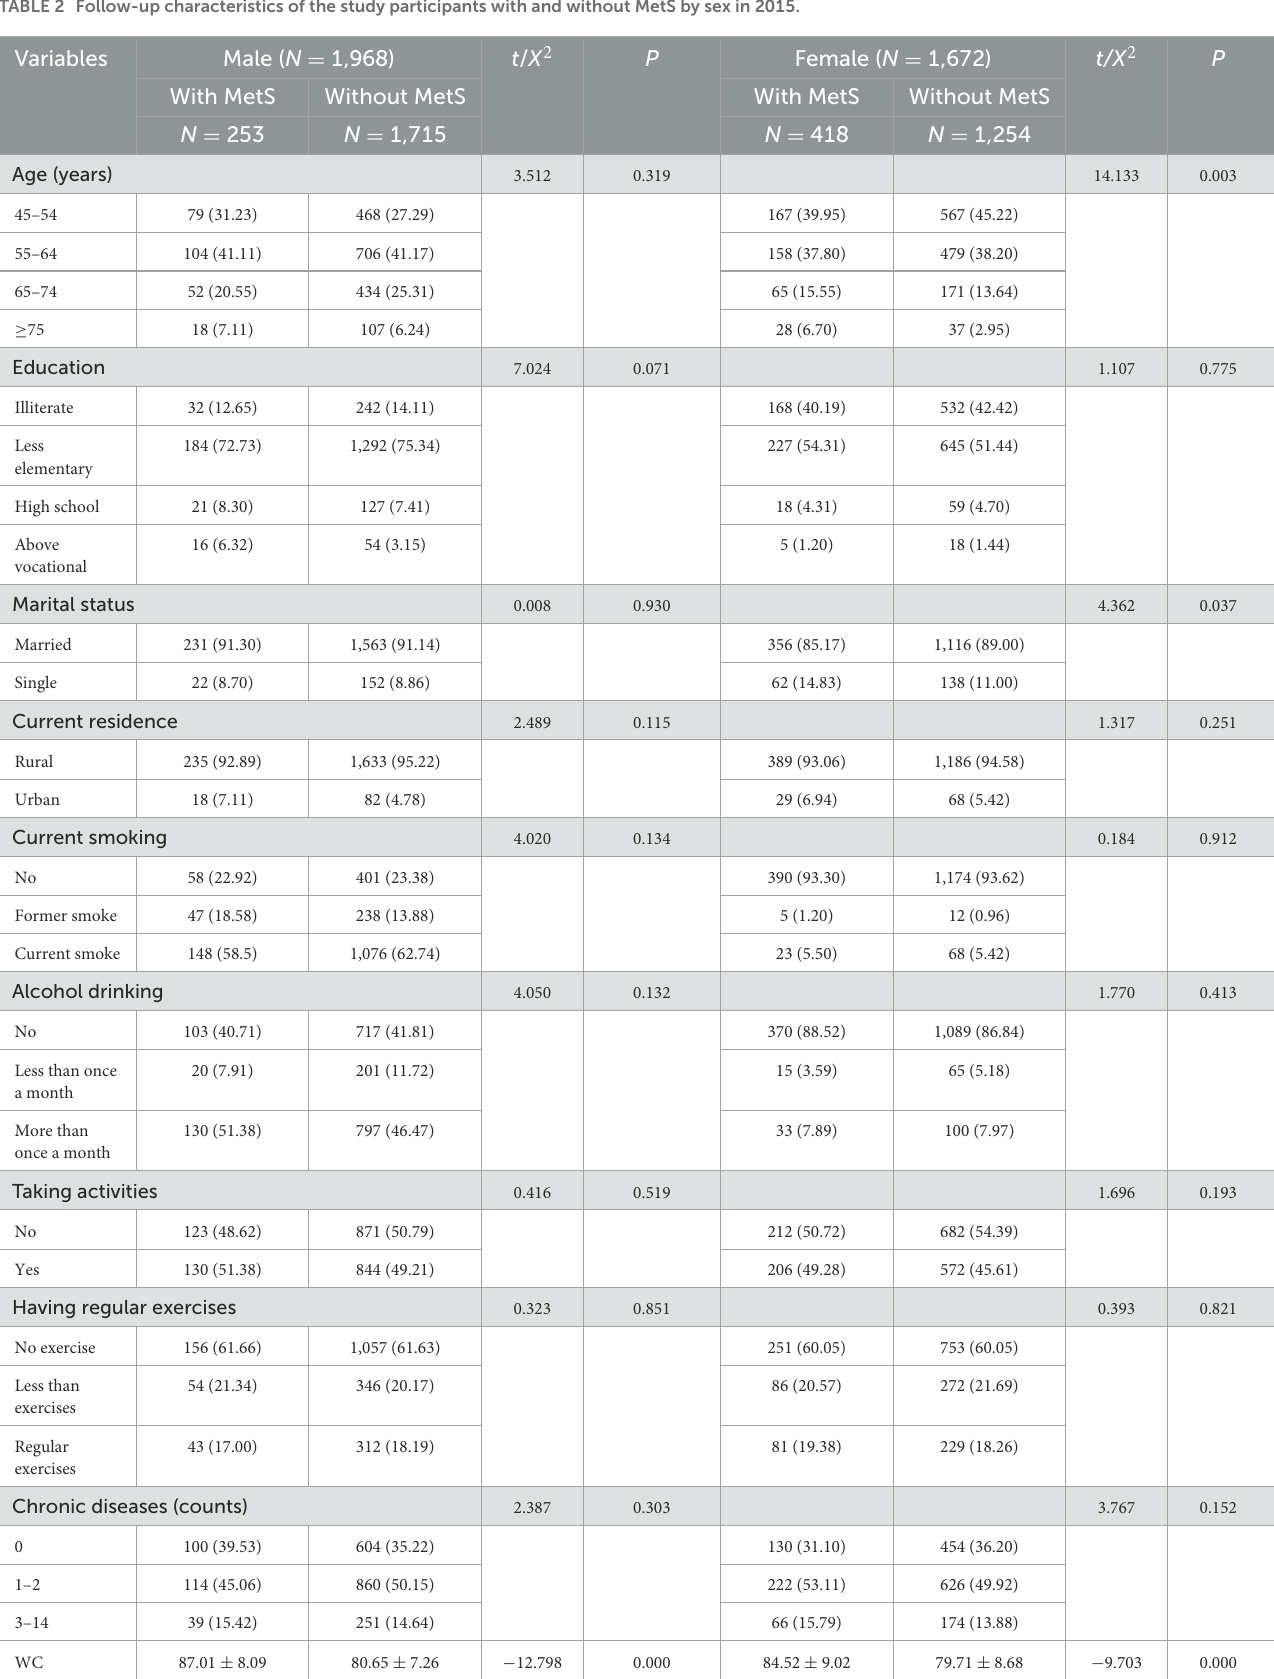
TABLE 2 Follow-up characteristics of the study participants with and without MetS by sex in